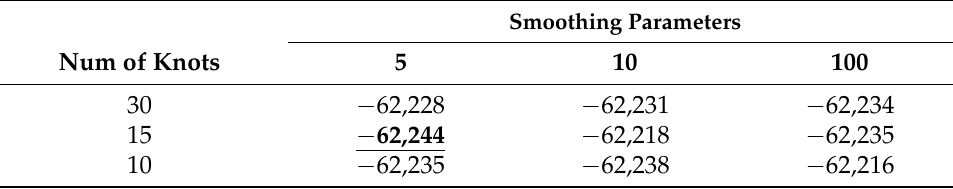
The best of each distribution is underlined, and the best overall is in bold. Table 15. DIC for Weibull distribution (27 July 2016, AGH, Tokyo, Japan). Smoothing Parameters